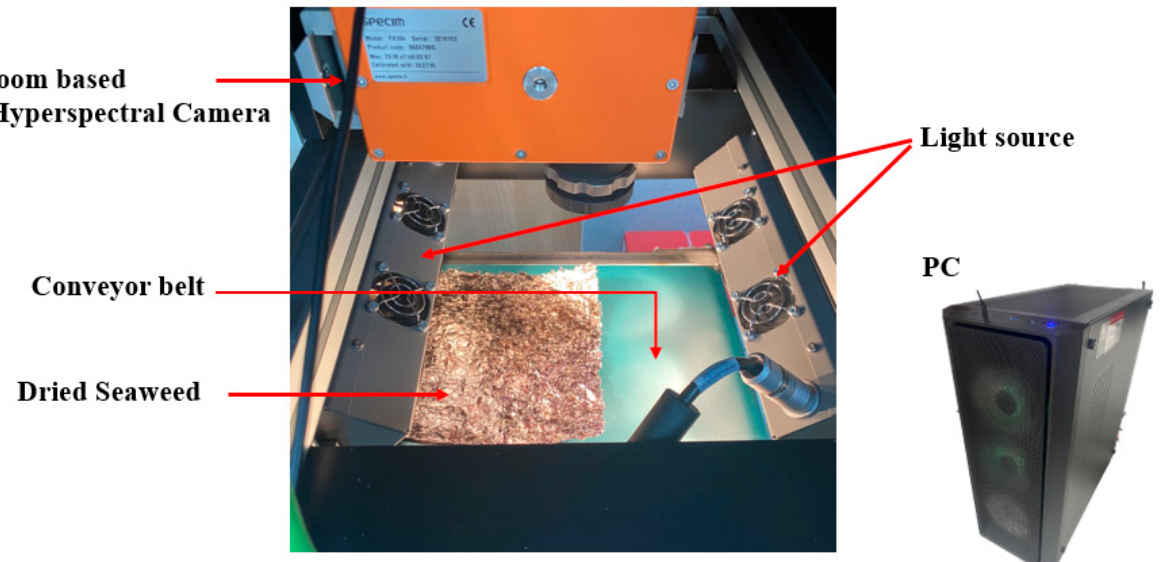
Figure 2. The VNIR hyperspectral imaging system used in the experiment.